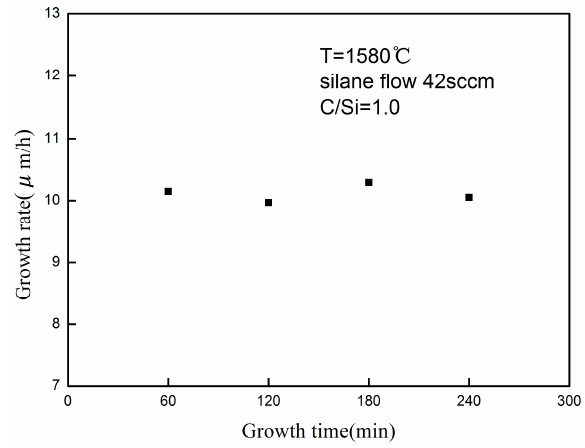
Figure 3. Growth rate of 4H-SiC epitaxial layers for various growth time.